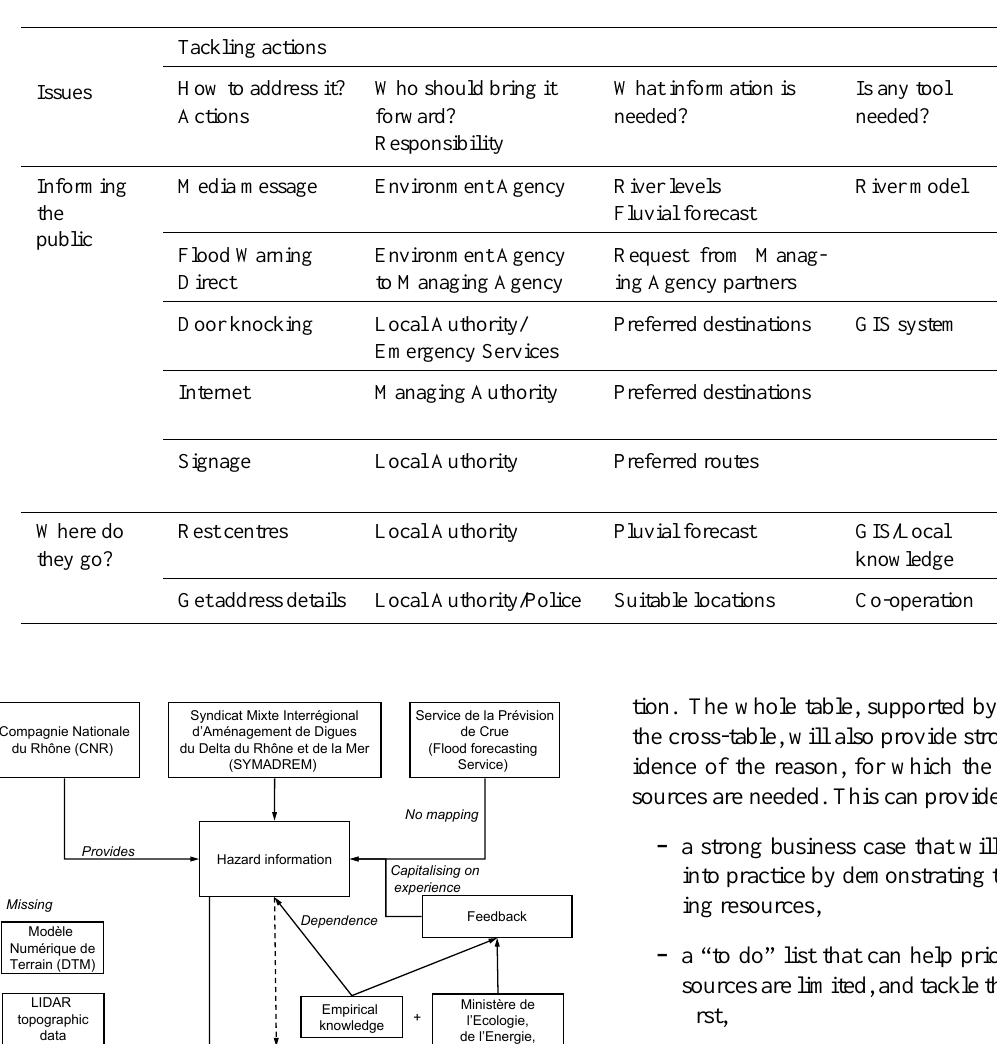
Table 4. Action table for the evacuation of Sheffield.